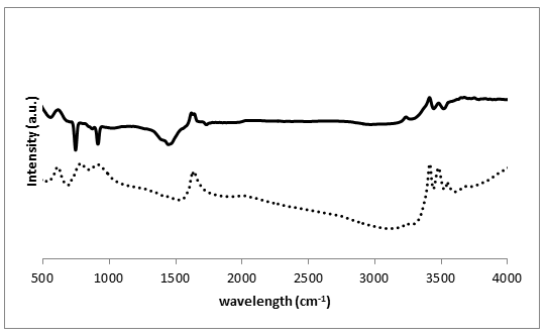
Figure 8. FT-IR spectra of AC(NaOH) before(?)and after adsorption (....)of chromium VI.